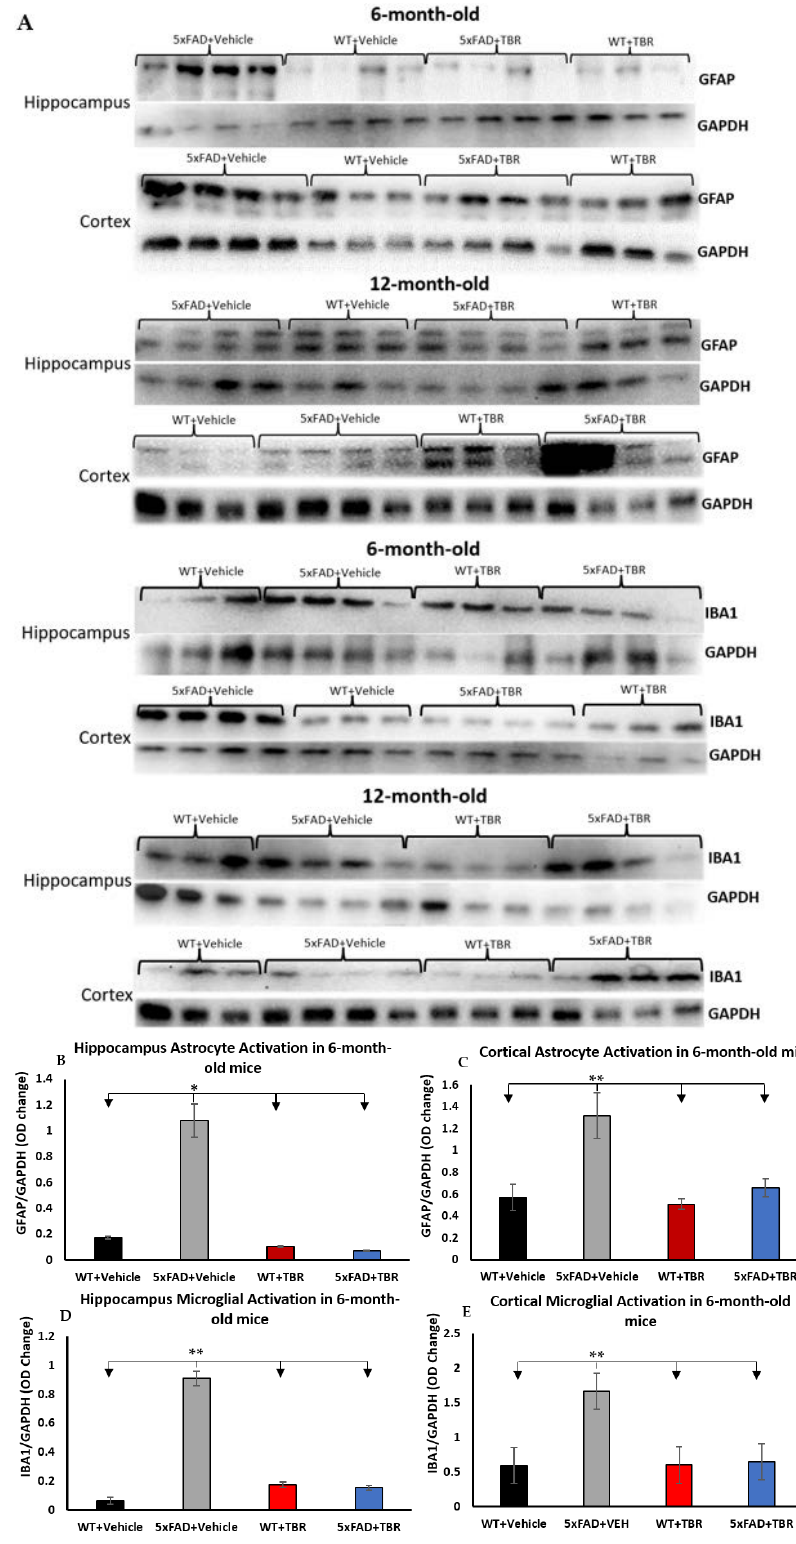
Figure 12. Western blots of GFAP and Iba1 levels in 6- and 12-month-old mice ( A ). There were between-group significant difference in hippocampal and cortical GFAP and Iba1 levels in the 6-month-old mice, but no significant between-group differences were observed in these measures for the 12-month-old mice ( B – E ). * p < 0.05; ** p < 0.05 for the 5xFAD mice, when compared with all other groups. Blots are representative images.